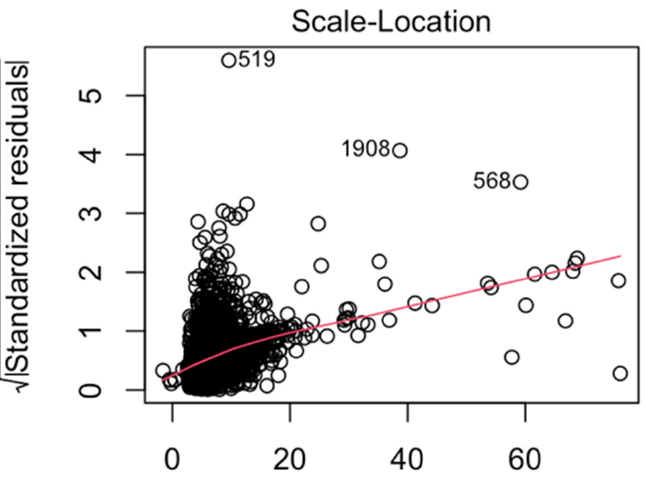
Figure 2. The linear relationship between independent variables and dependent variables. Normal